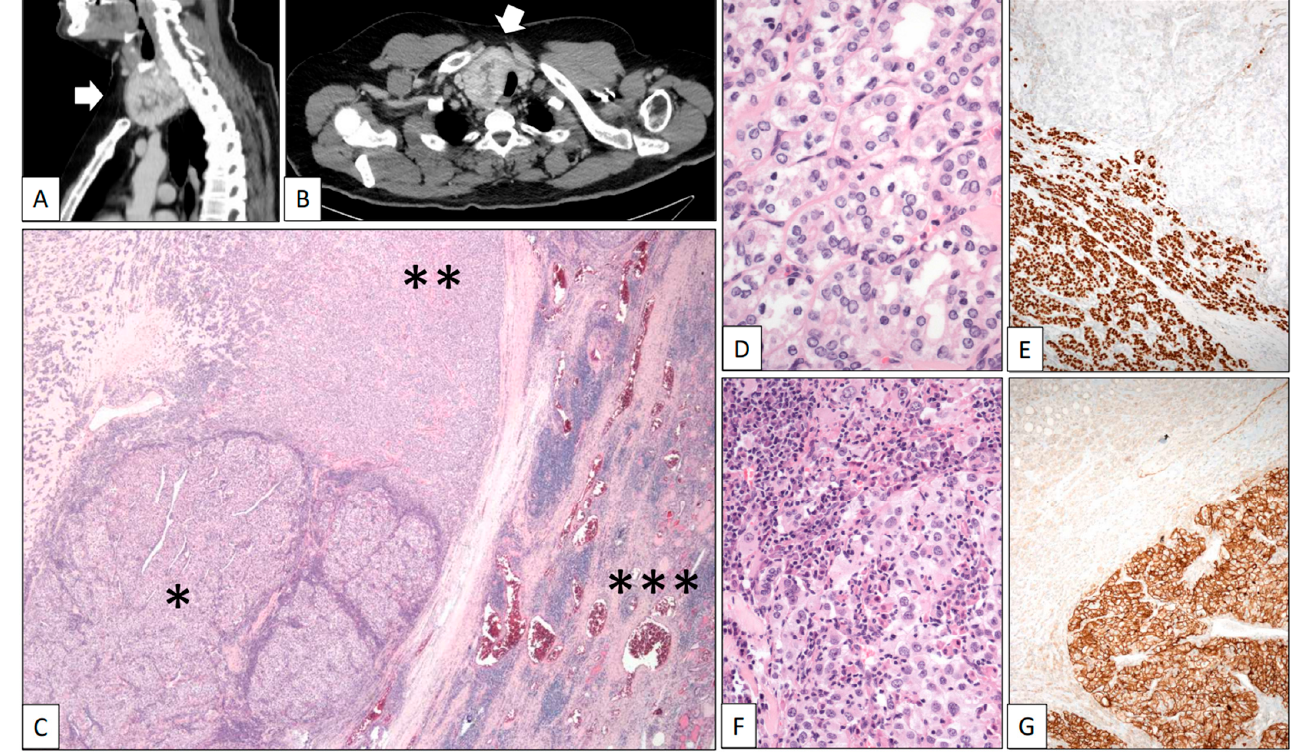
Figure 3. Clear cell renal cell carcinoma metastasizing in papillary carcinoma of the thyroid. ( A ) Sagittal and ( B ) axial CT scans showing a large heterogeneous tumor mass in the thyroid (white arrows). ( C ) Panoramic view of the surgical specimen displaying a tumor mass (left-lower quadrant corresponding to the renal cell carcinoma *) within a bigger mass (corresponding to the papillary carcinoma **) growing in the thyroid gland (right side ***). High-power detail showed a follicular variant of papillary thyroid carcinoma with characteristic nuclear features ( D ) positive with TTF-1 ( E ) and an inflamed renal cell carcinoma ( F ) positive with carbonic anhydrase IX ( G ). Case 4. CCRCC infiltrated by chronic lymphocytic leukemia.